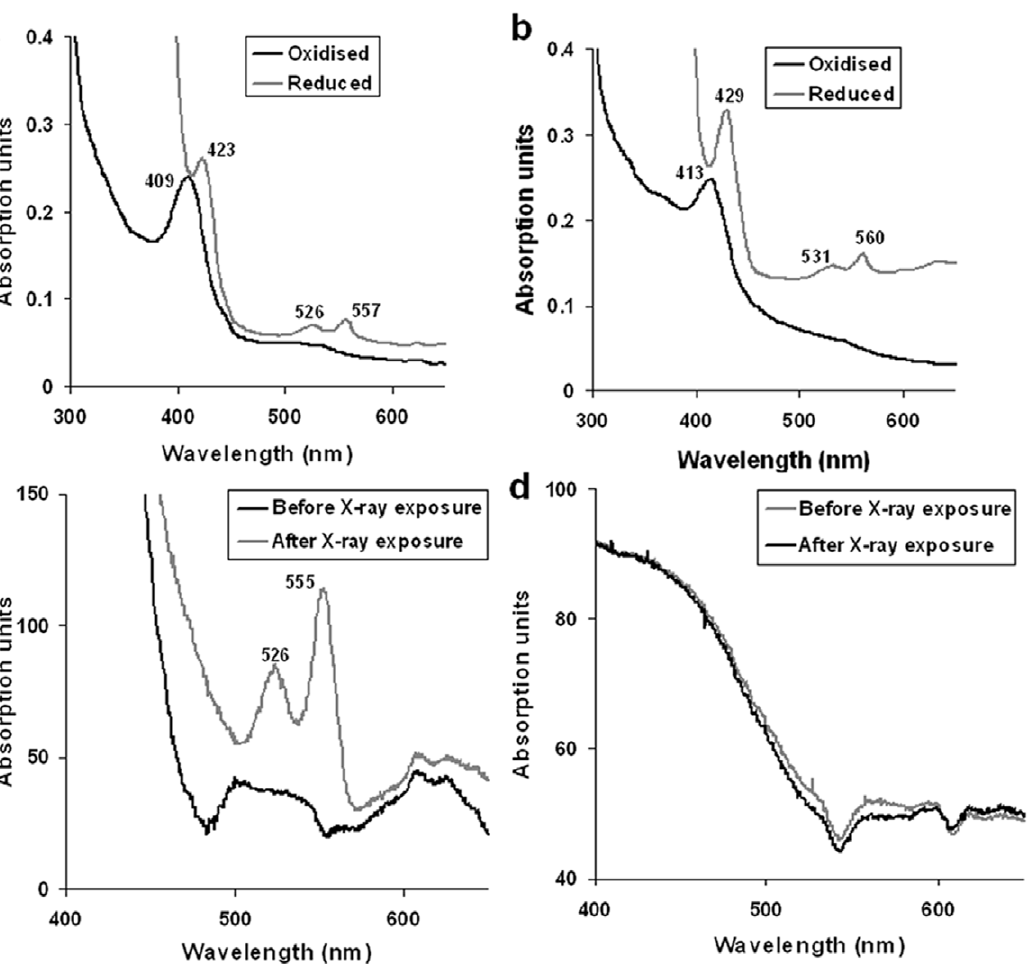
Figure 2. Spectral studies of Mtb native and SeMet BfrAs in solution and crystalline form. U.V.-visible spectra of ( a ) Native and ( b ) SeMet BfrA in oxidized (black) and reduced (gray) states. Single crystal microspectrophotometry at 100 K on crystals of ( c ) Native and ( d ) SeMet BfrA, before (black) and after (gray) X-ray exposure.